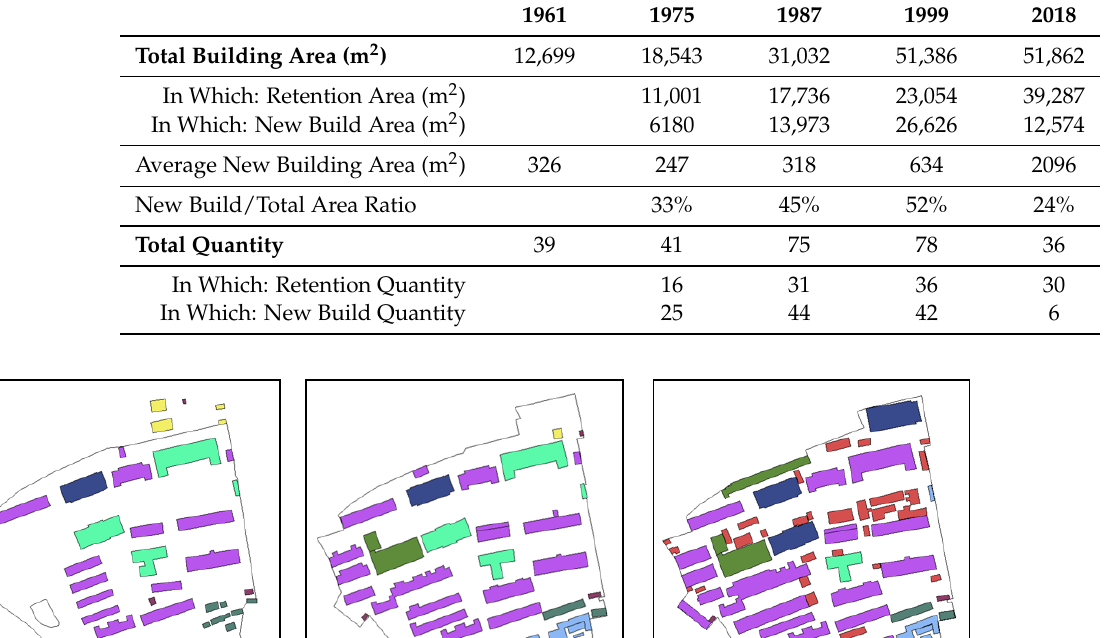
Table 5. Building area and quantity in the AMS compound (1961–2018).